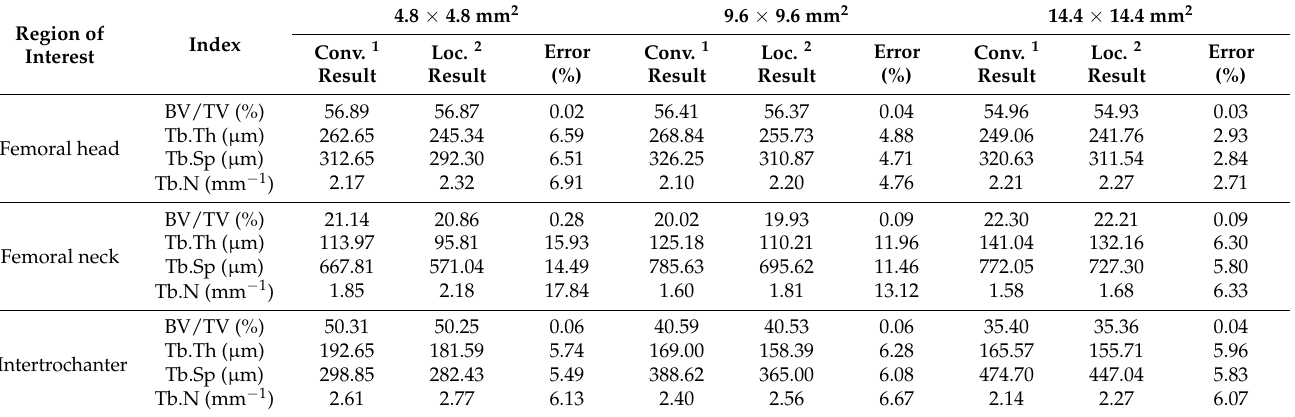
Table 2. Comparison of trabecular morphometric indices between the conventional and localized